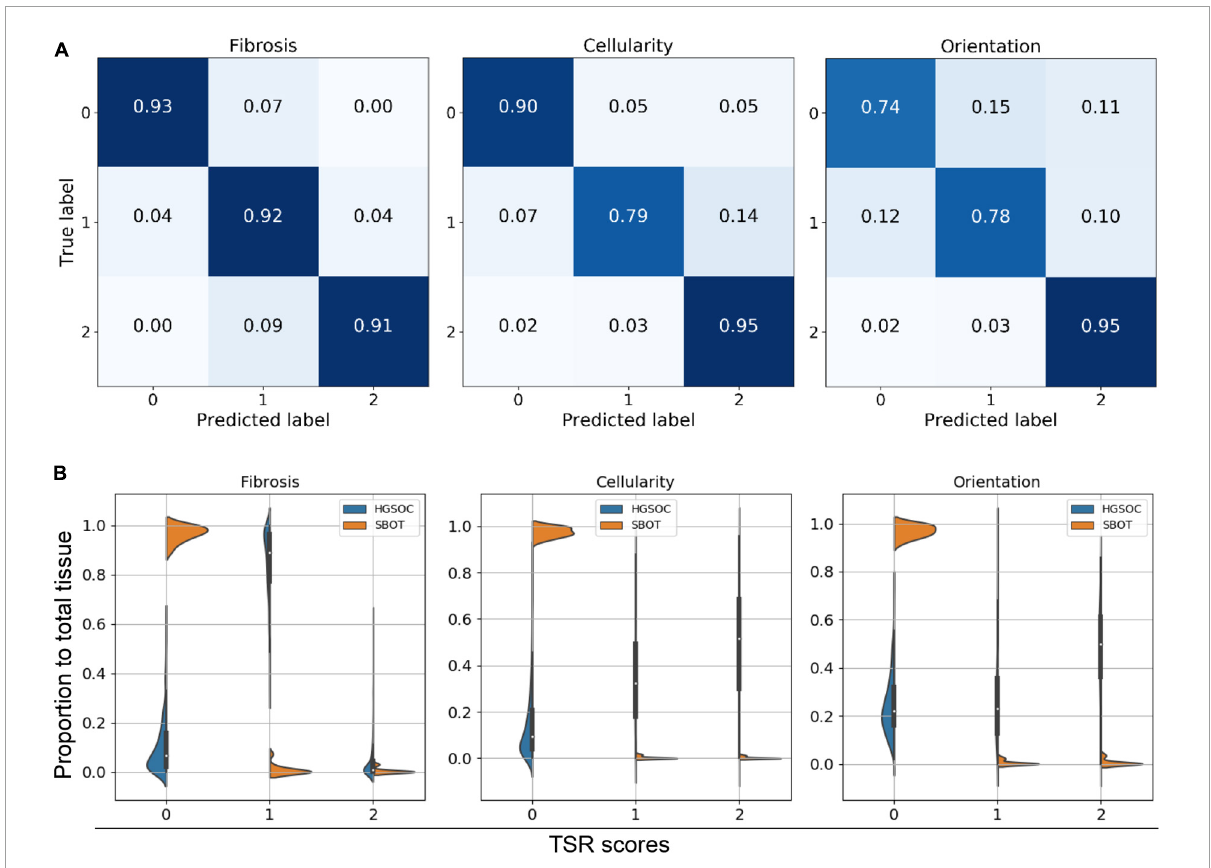
FIGURE4 Tumor-stroma reaction (TSR) scoring evaluation. (A) Confusion matrix of intrinsic evaluation. (B) Violine plot for three TSR metrics within HGSOC vs. SBOT. Majority of SBOT images have low TSR score, no matter in which